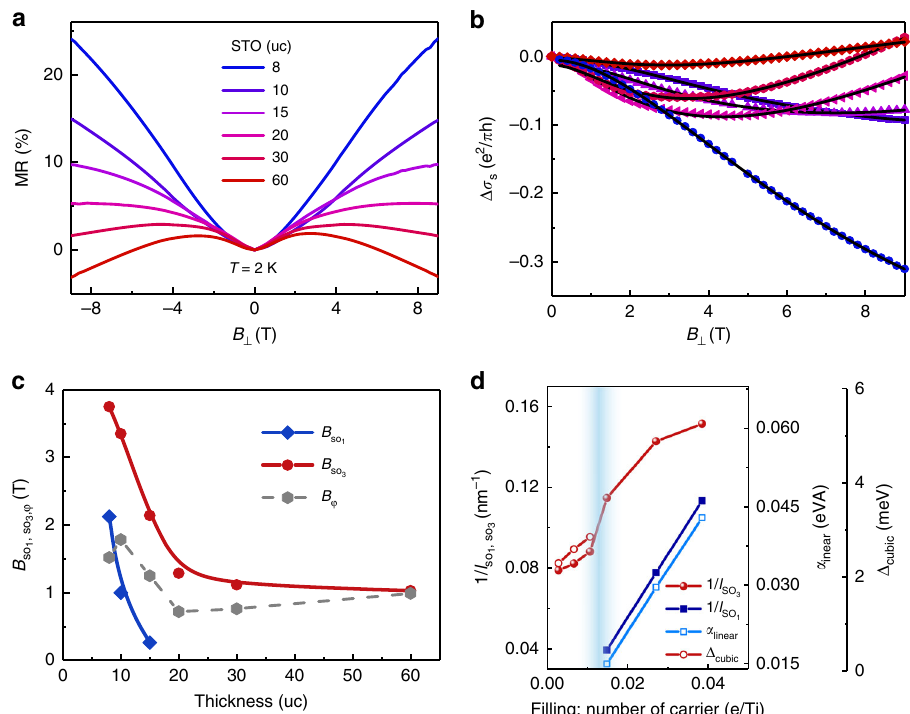
Fig. 5 Spin splitting modulated by carrier- fi lling. a Evolution of magnetoresistance at 2 K for the LAO//STO/LAO oxide heterostructures with various STO thicknesses. b Fitting (lines) of the magnetoconductance data (symbols) to the Iordanskii, Lyanda-Geller, and Pikus model. c Thickness-dependent fi tting parameters: B so1 and B so3 are the characteristic fi elds of the linear and cubic Rashba terms, respectively, and B φ is the characteristic fi eld for the phase coherence. d Inverse spin relaxation lengths, linear Rashba coef fi cient α linear , and spin splitting energy Δ cubic as a function of the fi lling carriers per Ti in the